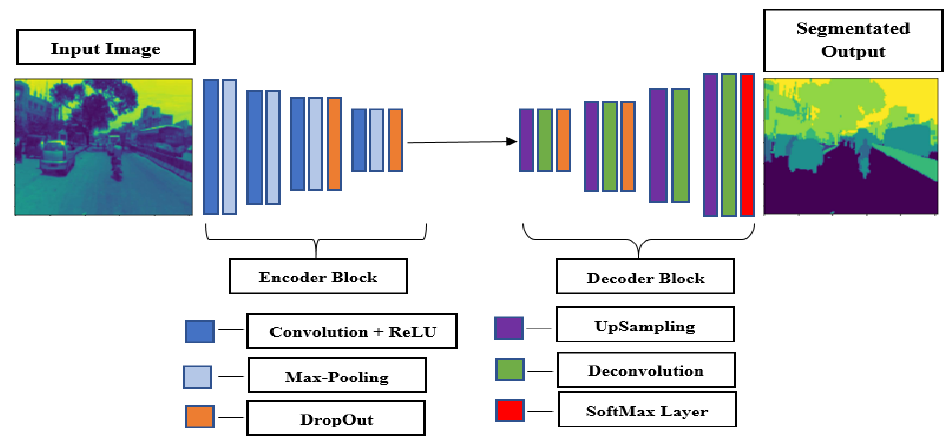
Figure 1. The general design of encoder-decoder-based Semantic Segmentation Models (SSM).